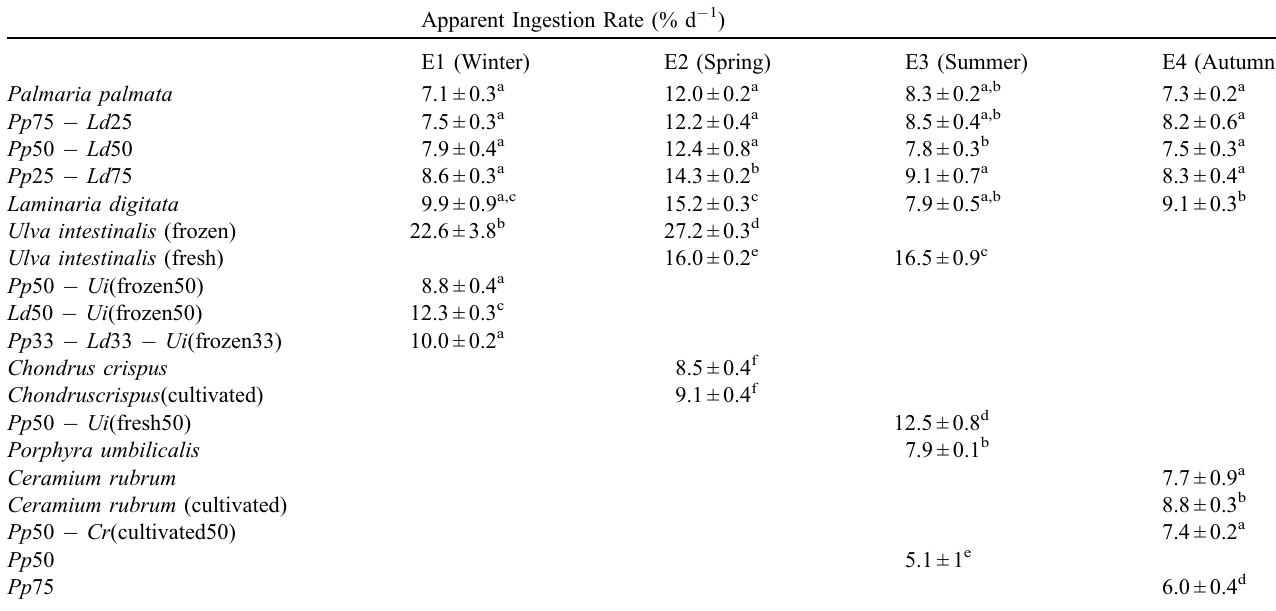
Table 4. Mean and con fi dence interval ( a = 0.05) of apparent ingestion rates (AIR) bytesting period: Pp : Palmaria palmata , Ld : Laminaria digitata , Ui : Ulva intestinalis , Cr : Ceramnium rubrum , Pp 25 (cid:3) Ld 75: a diet composed of 25% P. palmata and 75% L. digitata . Pp 75%: diet consisting of 75% of the amount of P. palmata consumed when supplied ad libitum .For each season, diets that do not share a letter signi fi cantly differ (ANOVA and SNK tests, p < 0.05).